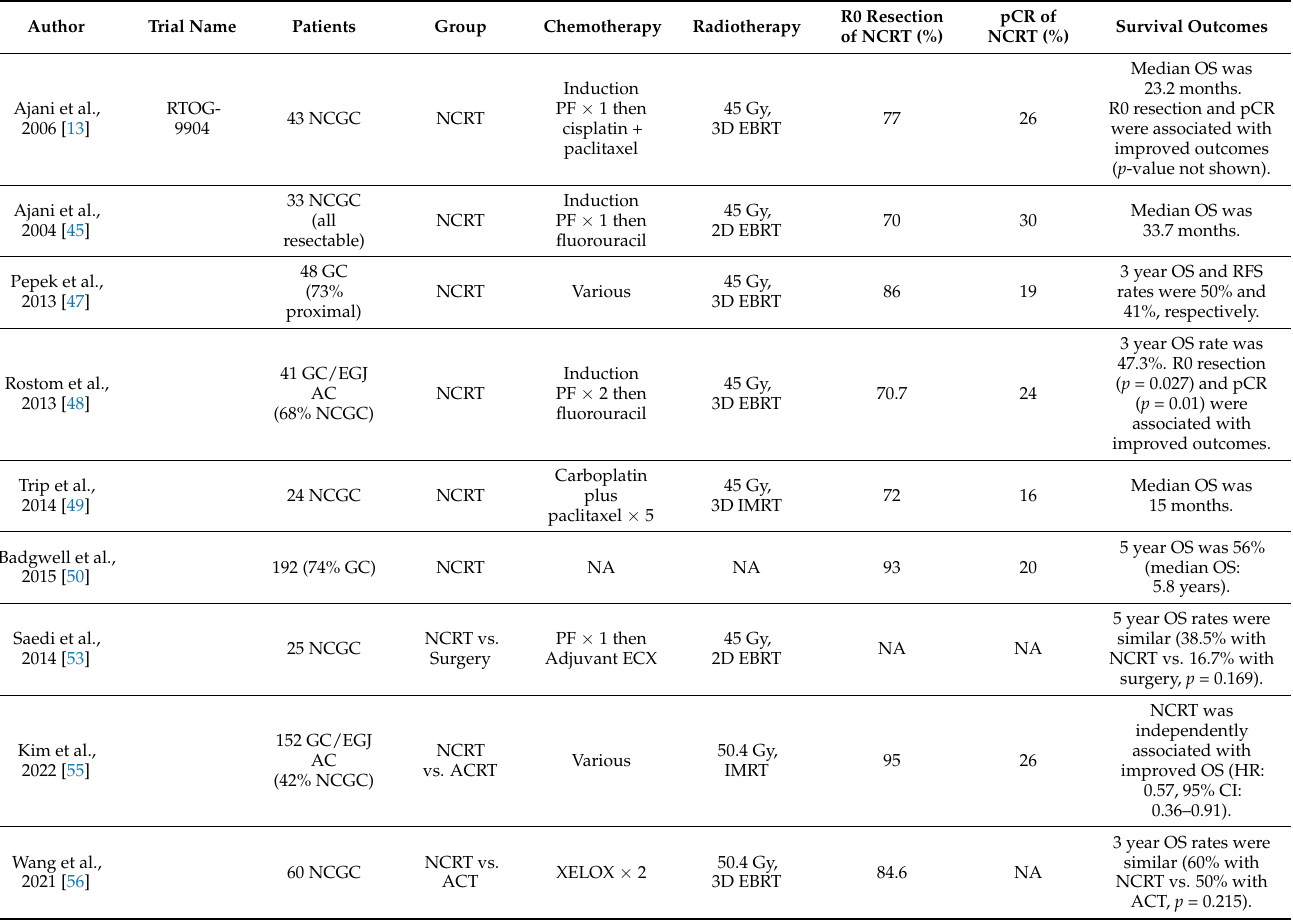
Table 2. Studies examining neoadjuvant chemoradiotherapy (NCRT) for locally advanced gastric cancers (LAGC) in comparison with surgery alone or adjuvant